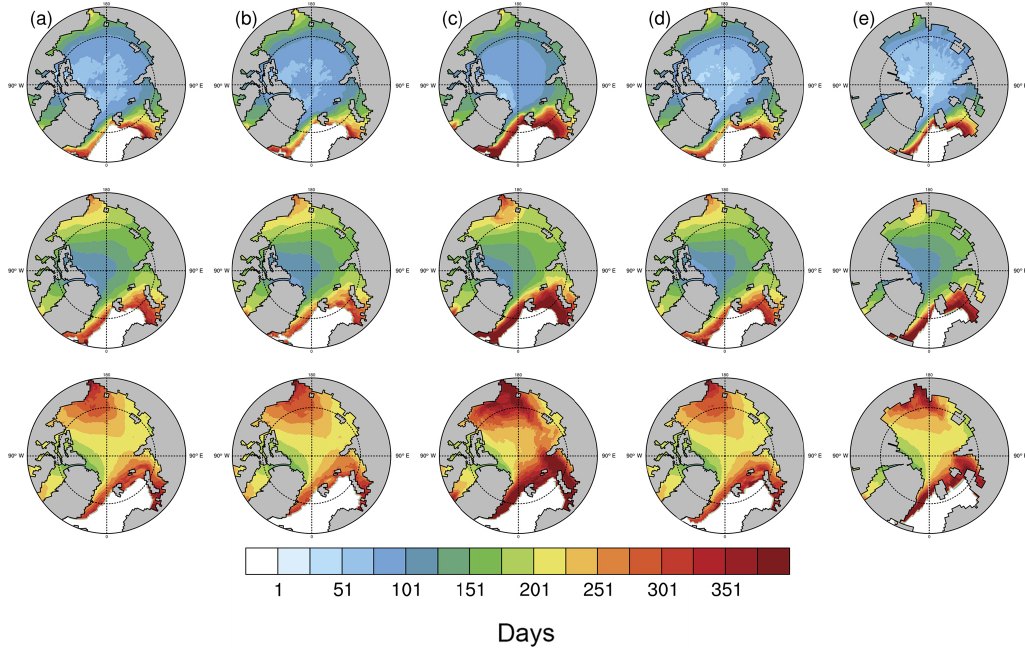
Figure 13. Melt season length averaged over the time periods 1979–1998 (top row), 2040–2059 (middle row) and 2080–2099 (bottom row) using ensemble member 35. Each column is a different definition: (a) congelation–snowmelt, (b) frazil–snowmelt, (c) volume–volume, (d) temperature–snowmelt and (e)